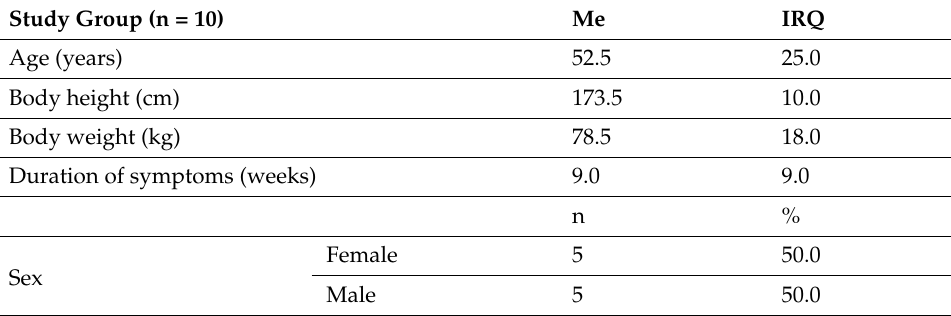
Table 1. Characteristics of the study